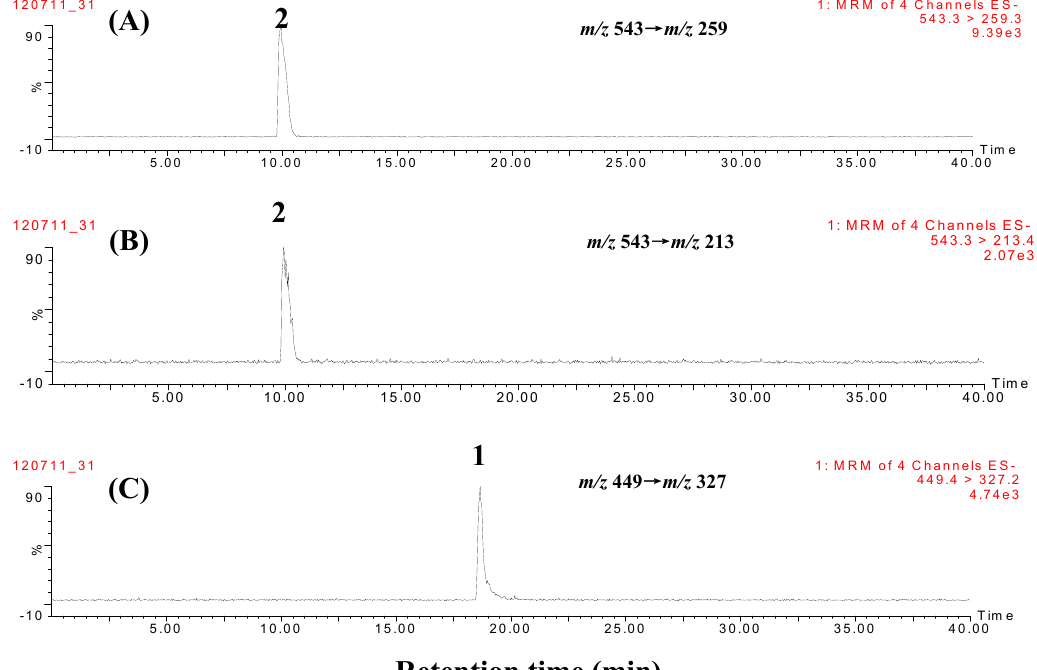
Figure 5. Representative chromatograms of different PAR-containing complex preparations by MRM scan. ( A ) XYW (JPACM-02-06) ion transition m/z 543 → m/z 259; ( B ) XYW (JPACM-02-06) ion transition m/z 543 → m/z 213; ( C ) XYW (JPACM-02-06) ion transition m/z 449 → m/z 327; ( D ) XYW (JPACM-02-06) ion transition m/z 449 → m/z 165; ( E ) MRW (JPACM-02-05) ion transition m/z 543 → m/z 259; ( F ) MRW (JPACM-02-05) ion transition m/z 543 → m/z 213; ( G ) MRW (JPACM-02-05) ion transition m/z 449 → m/z 327; ( H ) MRW (JPACM-02-05) ion transition m/z 449 → m/z 165. 1 : paeoniflorin; 2 : paeoniflorin